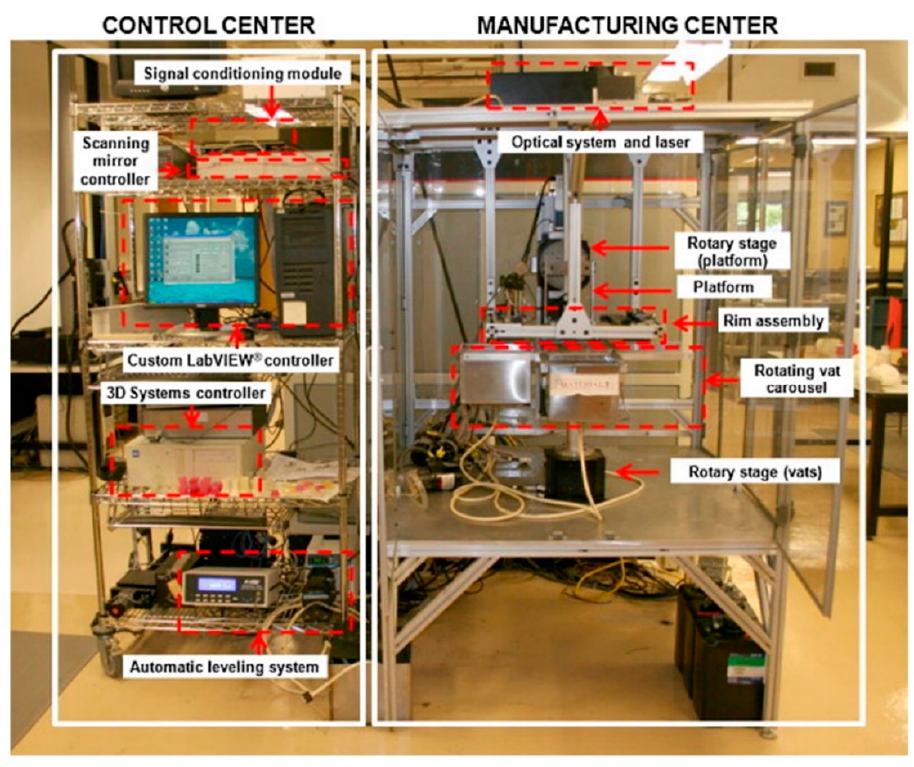
Figure 26. Multi-material SLA setup developed by Choi and coworkers, reproduced with permission from [57]. Copyright © 2022 Elsevier.